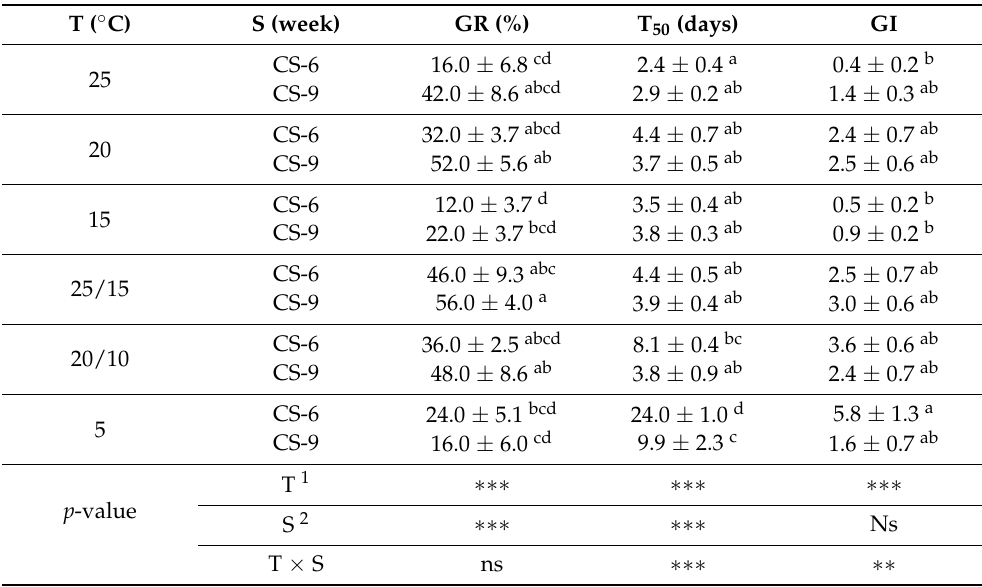
Table 2. The effect of cold (5 ◦ C) stratification and temperature treatments (for 6 or 9 weeks) on the germination vigor of L. coreana